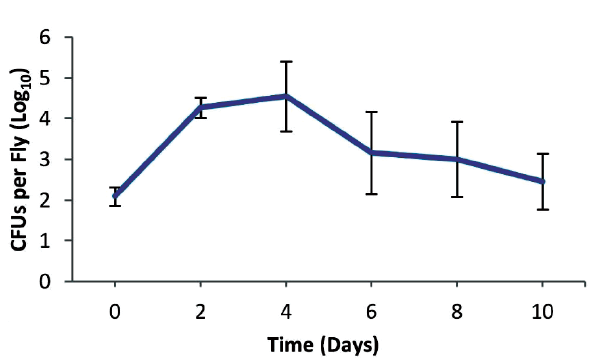
Figure 1. Persistence of Pseudomonas aeruginosa CF5 in the fly. Wild type Oregon R male flies were infected with 130 colony forming